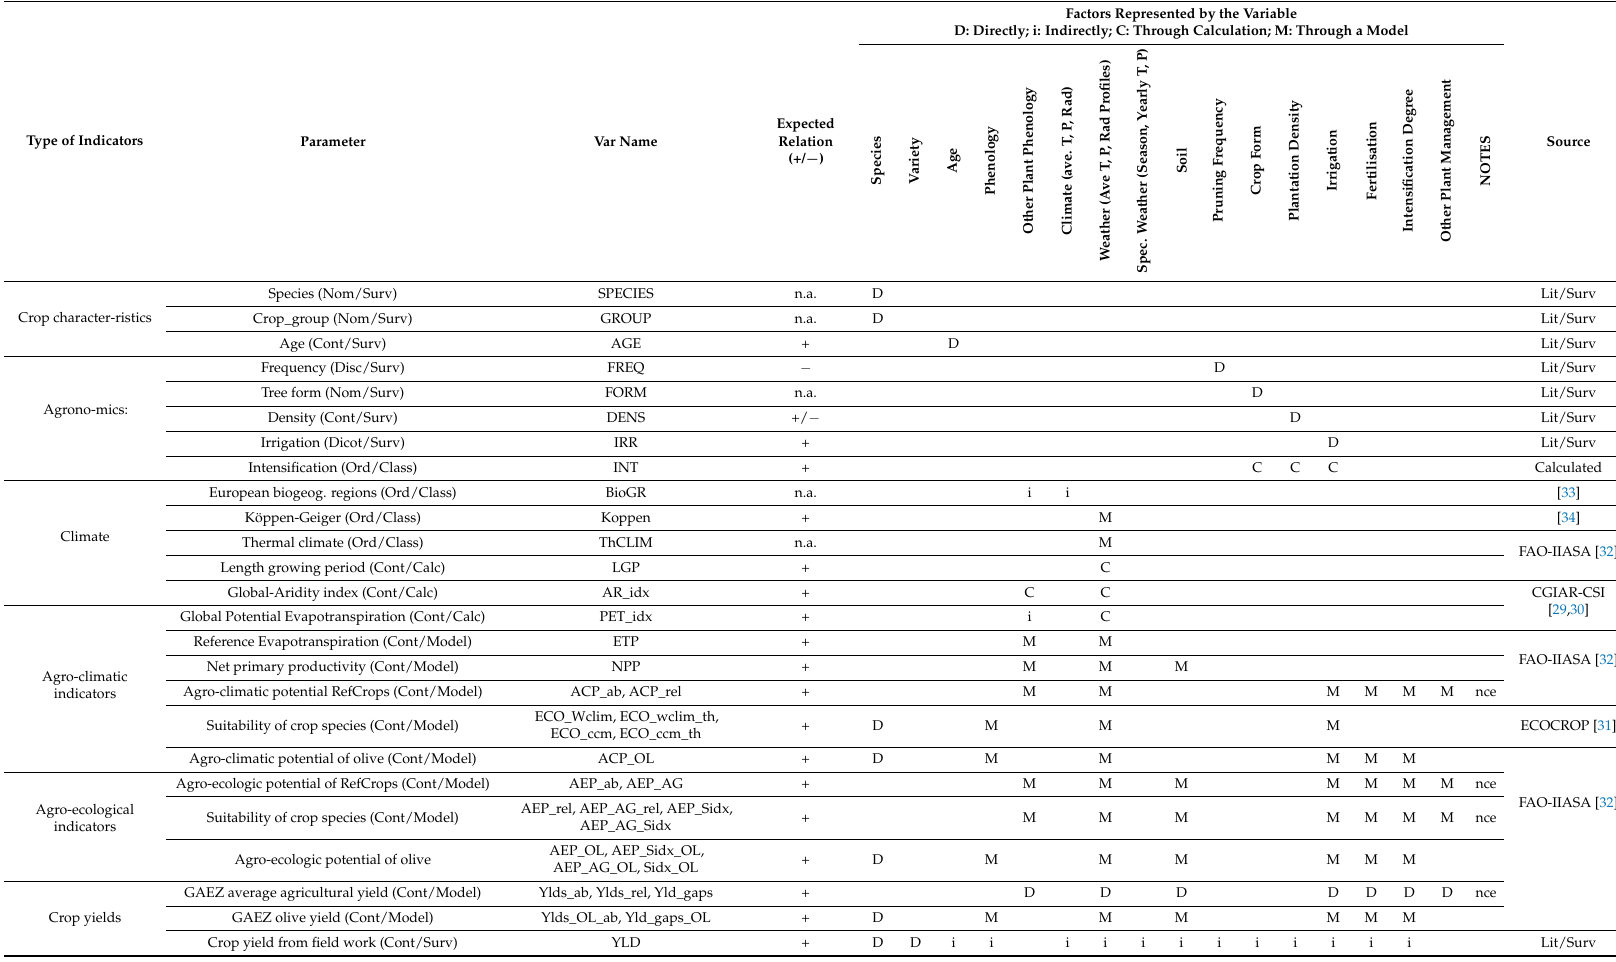
Table abbreviations: Variable types: Nom: nominal; Dic: Dichotomous; Ord: ordinal; Cont: continuous. Expected relation: +: direct positive relation; − : inverse relation; n.a.: not applicable. Column “Notes”: nce: not crop specific (meaning that it was built as an average of several crops to represent the potentiality of a site, not the potential of any of the targeted crop